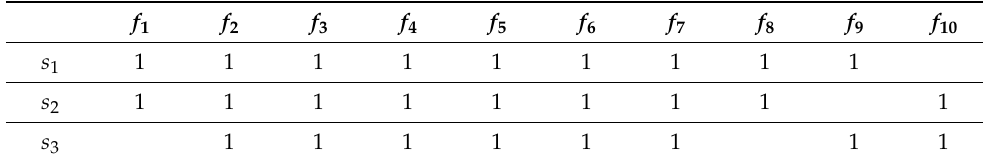
Table 5. Binary diagnostic